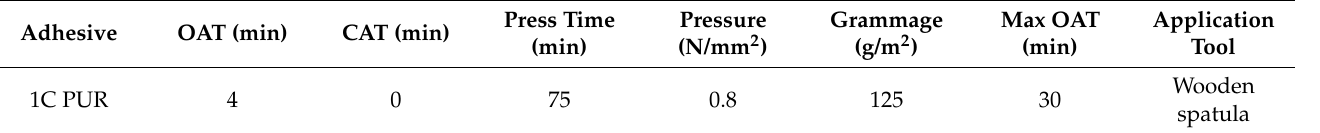
Table 2. Glueing parameters.